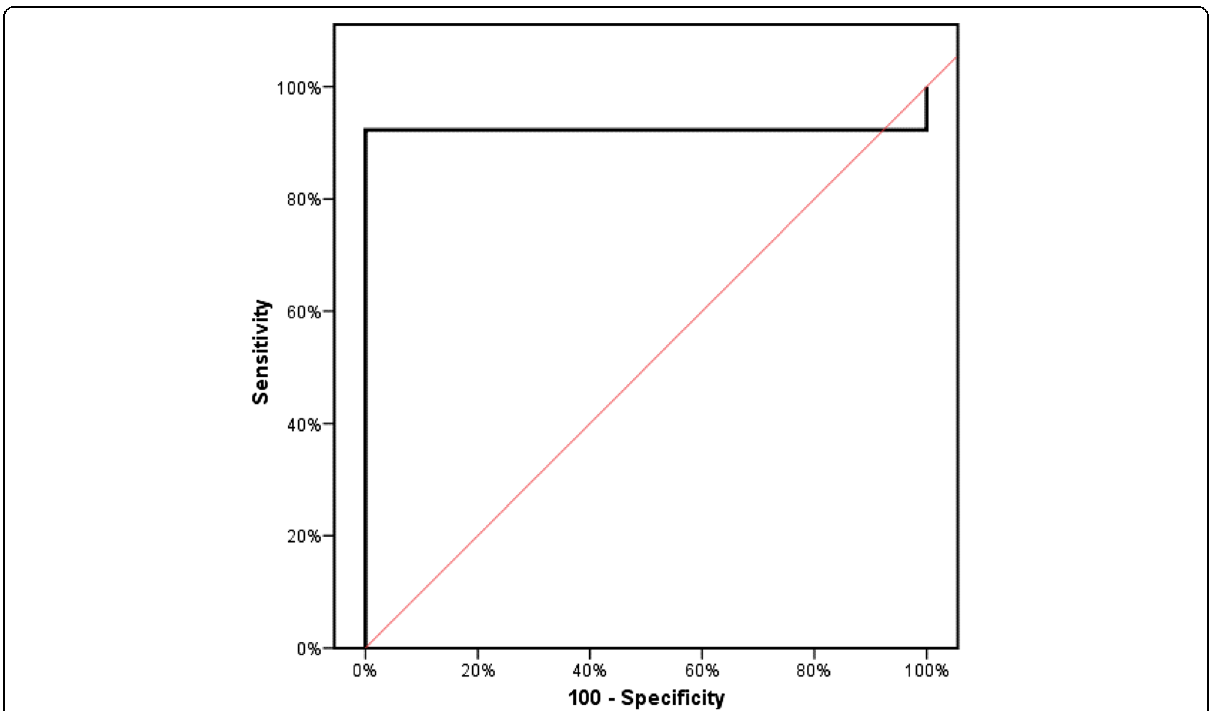
Fig. 3 ROC curve for % difference of ADC to diagnose non-responding